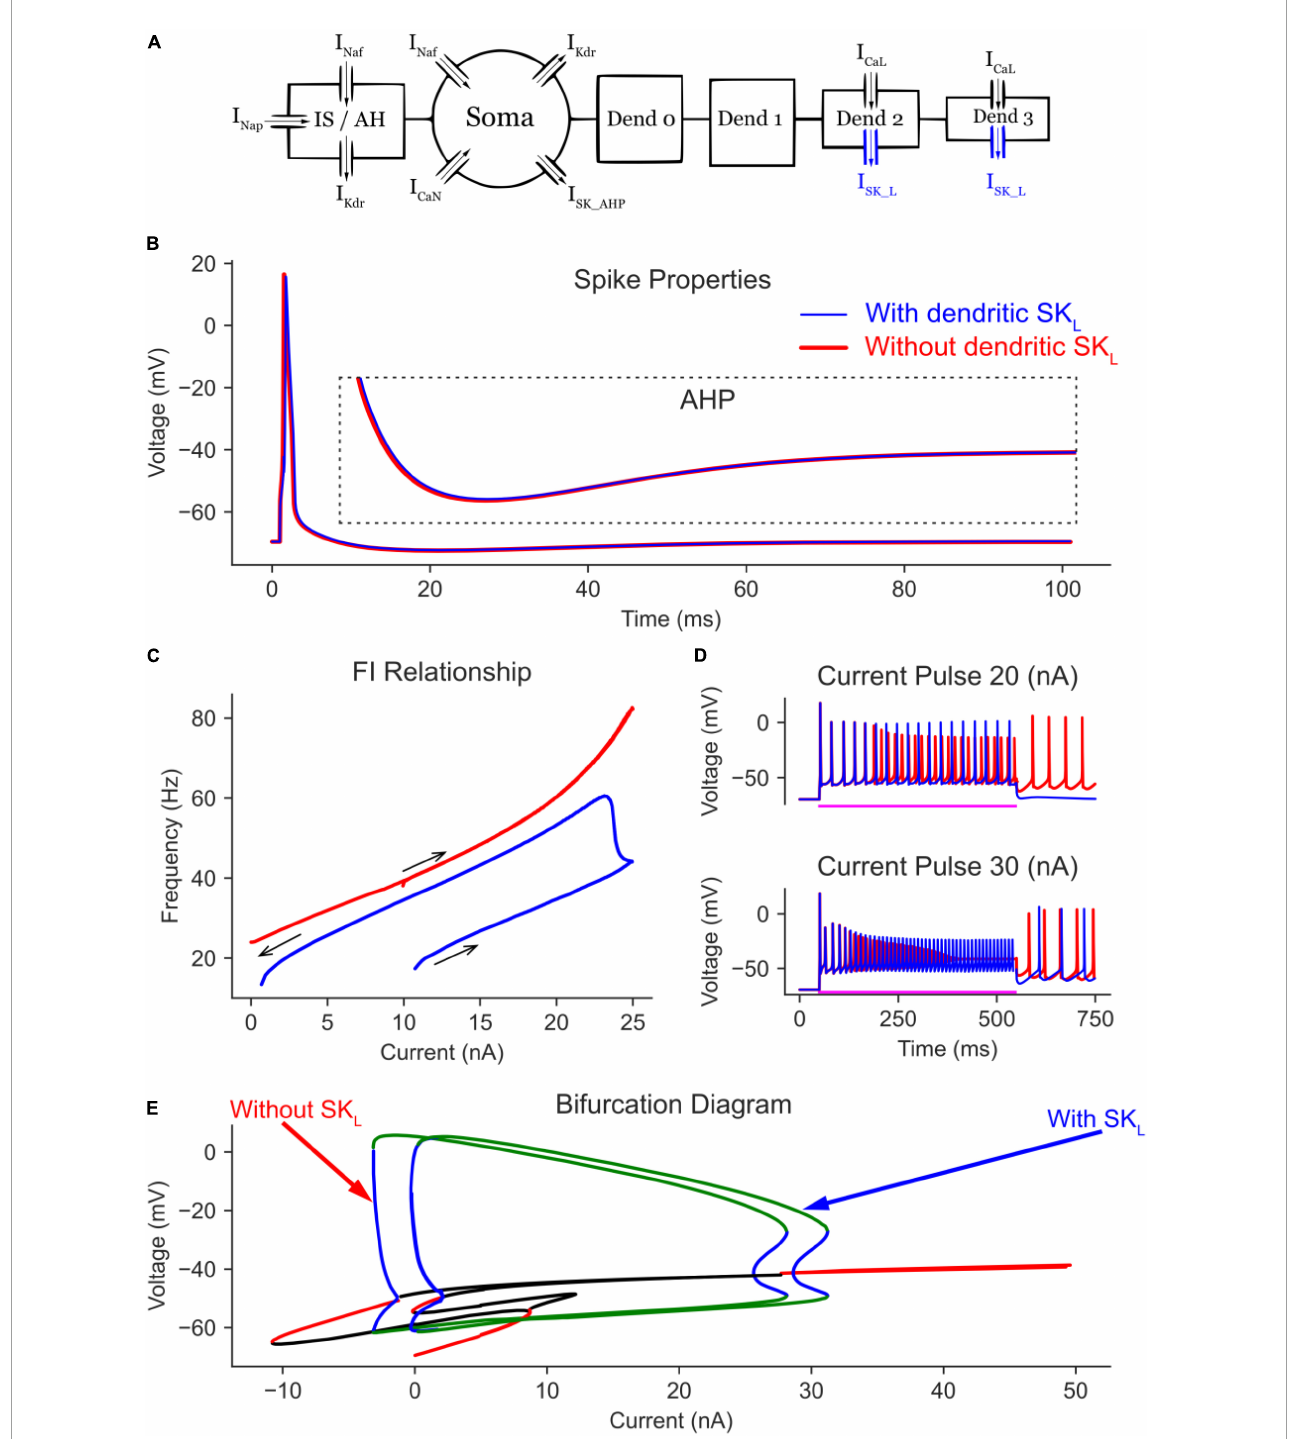
FIGURE5 The effect of dendritic SK_L channels on the MN model bifurcation diagram. (A) The 6C model morphology and the ion channels involved. Note the addition of SK channels to dendrites 2 and 3. The AP and AHP shapes (B) , F-I relationship (C) , and MN repetitive firing on long pulses (D) with (blue traces) and without (red traces) the dendritic SK channels included in the model. (E) The V-I bifurcation diagram of the MN model with and without the dendritic SK channels. In the diagram, the green and blue traces indicate the extrema of the stable and unstable limit cycles, respectively. The red and black traces show stable and unstable equilibrium points,